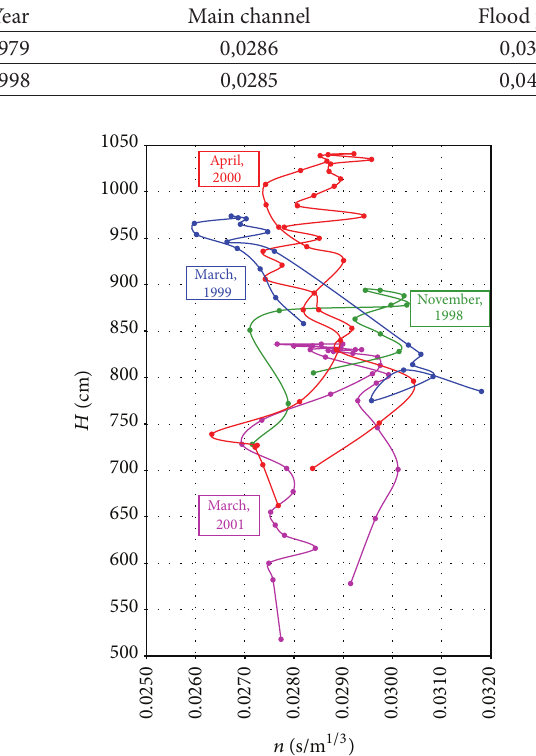
Figure 2: Variation of Manning’s coefficient of friction by water level, main bed at Szolnok.